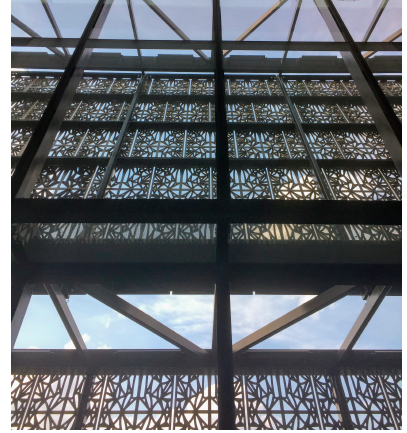
Figure 2. An interior view of the exterior panels at the National Museum of African American History and Culture, June 2017.